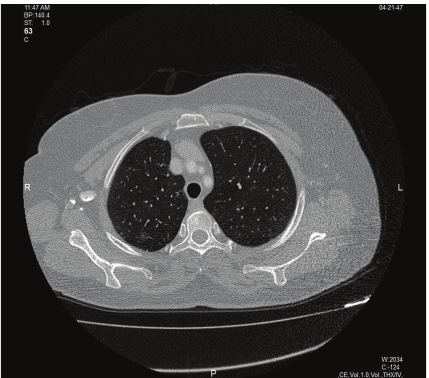
Figure 3: CT examination of the second patient, after 2 years from the lung